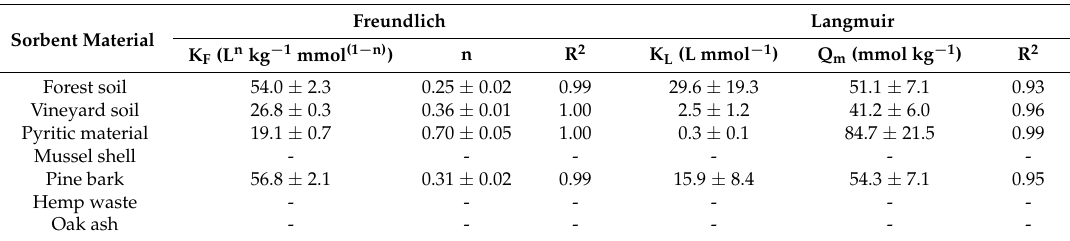
Table 2. Freundlich and Langmuir constants and R 2 values corresponding to Pb sorption on the soils and by-products studied. -: error values too high for